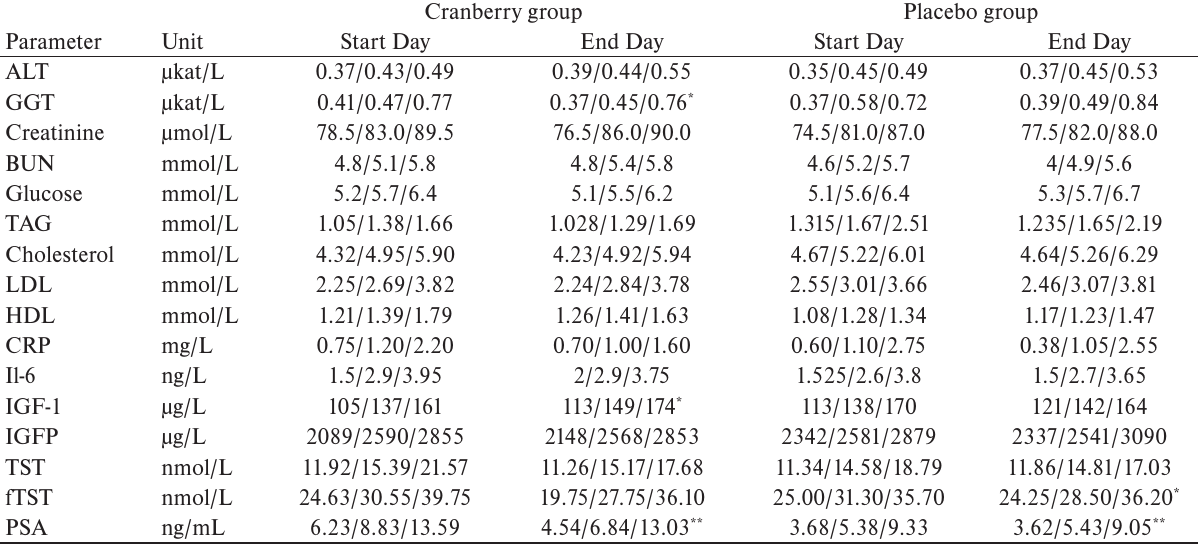
Table 4. Markers of clinical chemistry. Cranberry group Placebo group